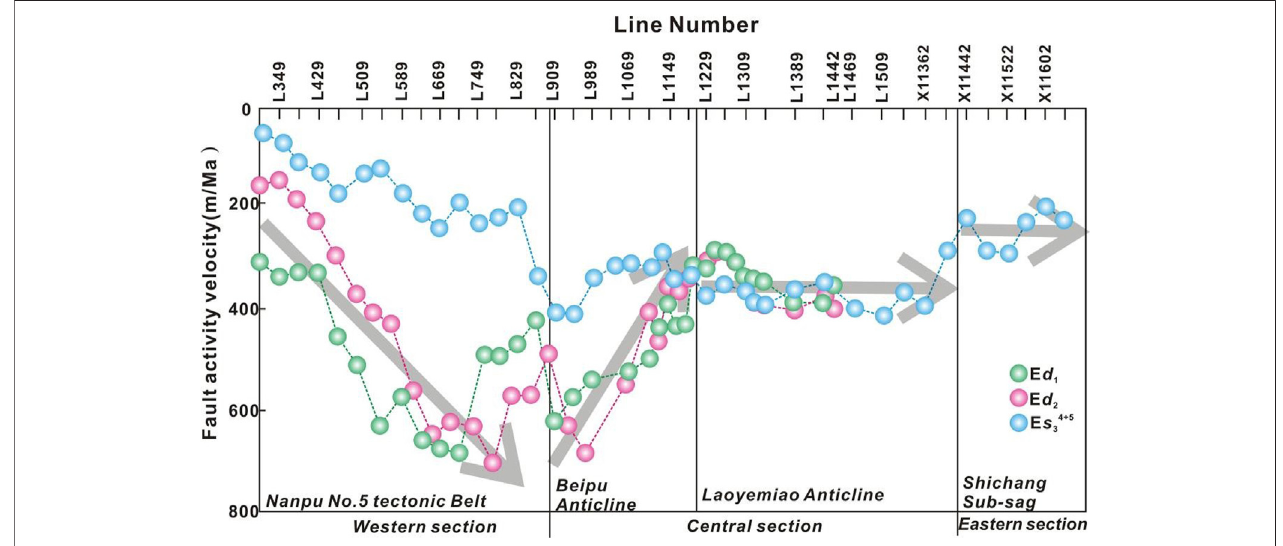
FIGURE 9 | The line charts of (A) ZTR index, (B) zircon, (C) tourmaline showing the prevenance distance changes by heavy minerals analyses of single-well.